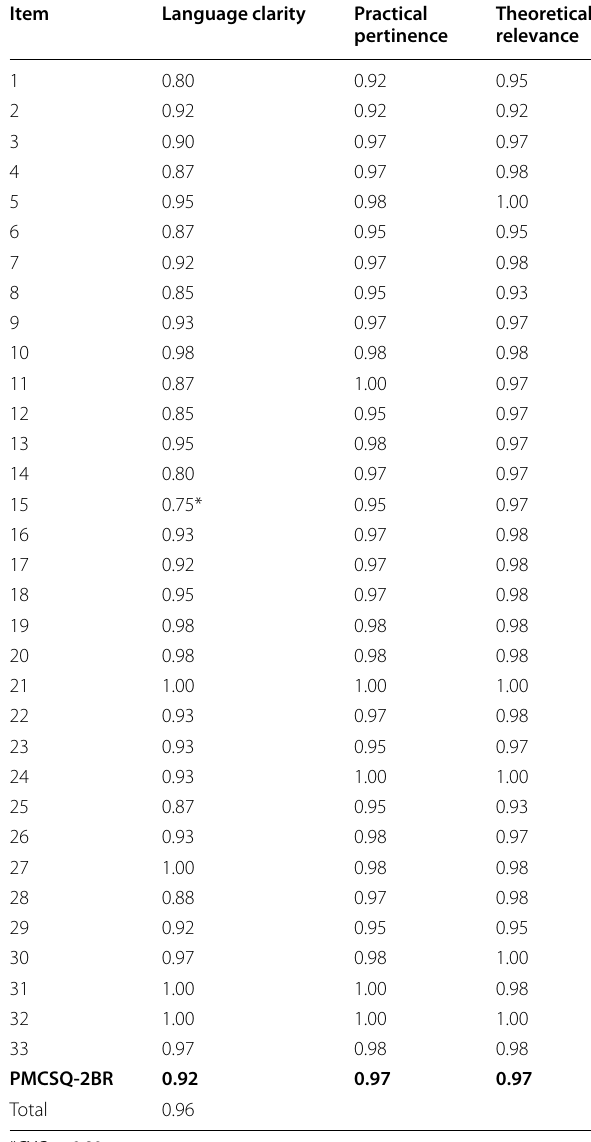
Table 1 Content validity coefficients (CVCc) of the 33 items and complete